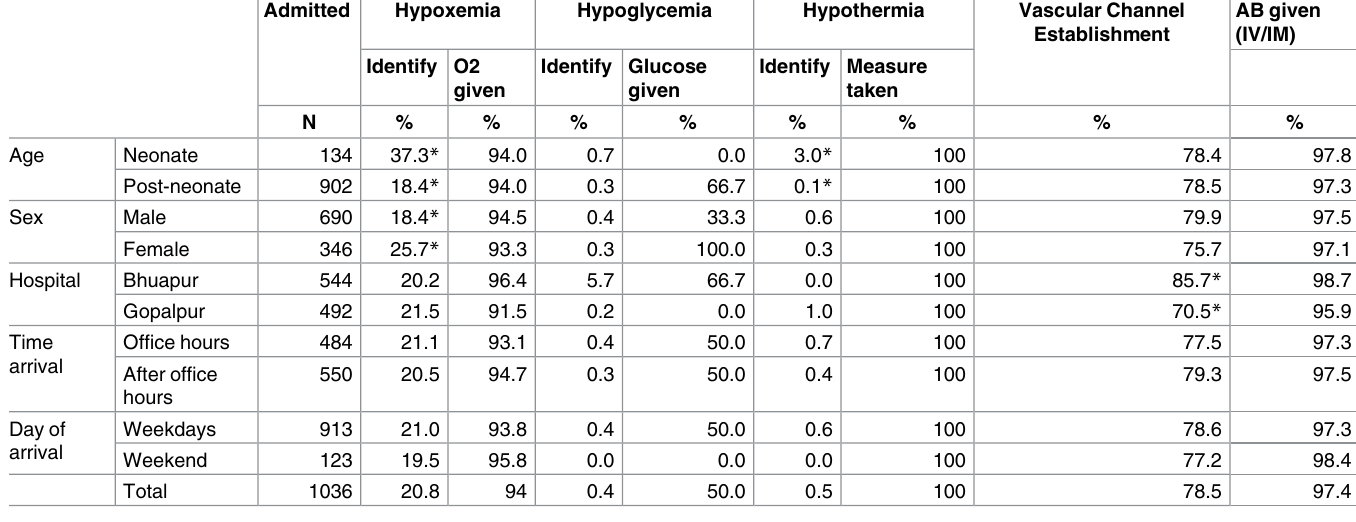
Table 1 summarizes quality of care related to ‘Fast Assessment’ of syndromic sepsis cases. Almost all the neonates and post neonates had their blood oxygen saturation level, blood glu- cose level, pulse rate, temperature and weight measured immediately after admission in the inpatient department. There was no significant variation among the stratifying variables. How- ever, only one third had their blood pressure measured with significant variation between age (neonate 3% and post neonate 38%; p < 0.005), hospitals (Bhuapur 8% vs Gopalpur 62%; p < 0.005) and time of arrival (office hours 29% vs after office hours 38%; p < 0.05). Table 2 presents the key findings regarding ‘Initial management and Immediate Resuscita- tion’ of syndromic sepsis patients in the inpatient department. One fifth of the syndromic Table 2. Status of Initial Management and Immediate Resuscitation of syndromic sepsis patients in the inpatient